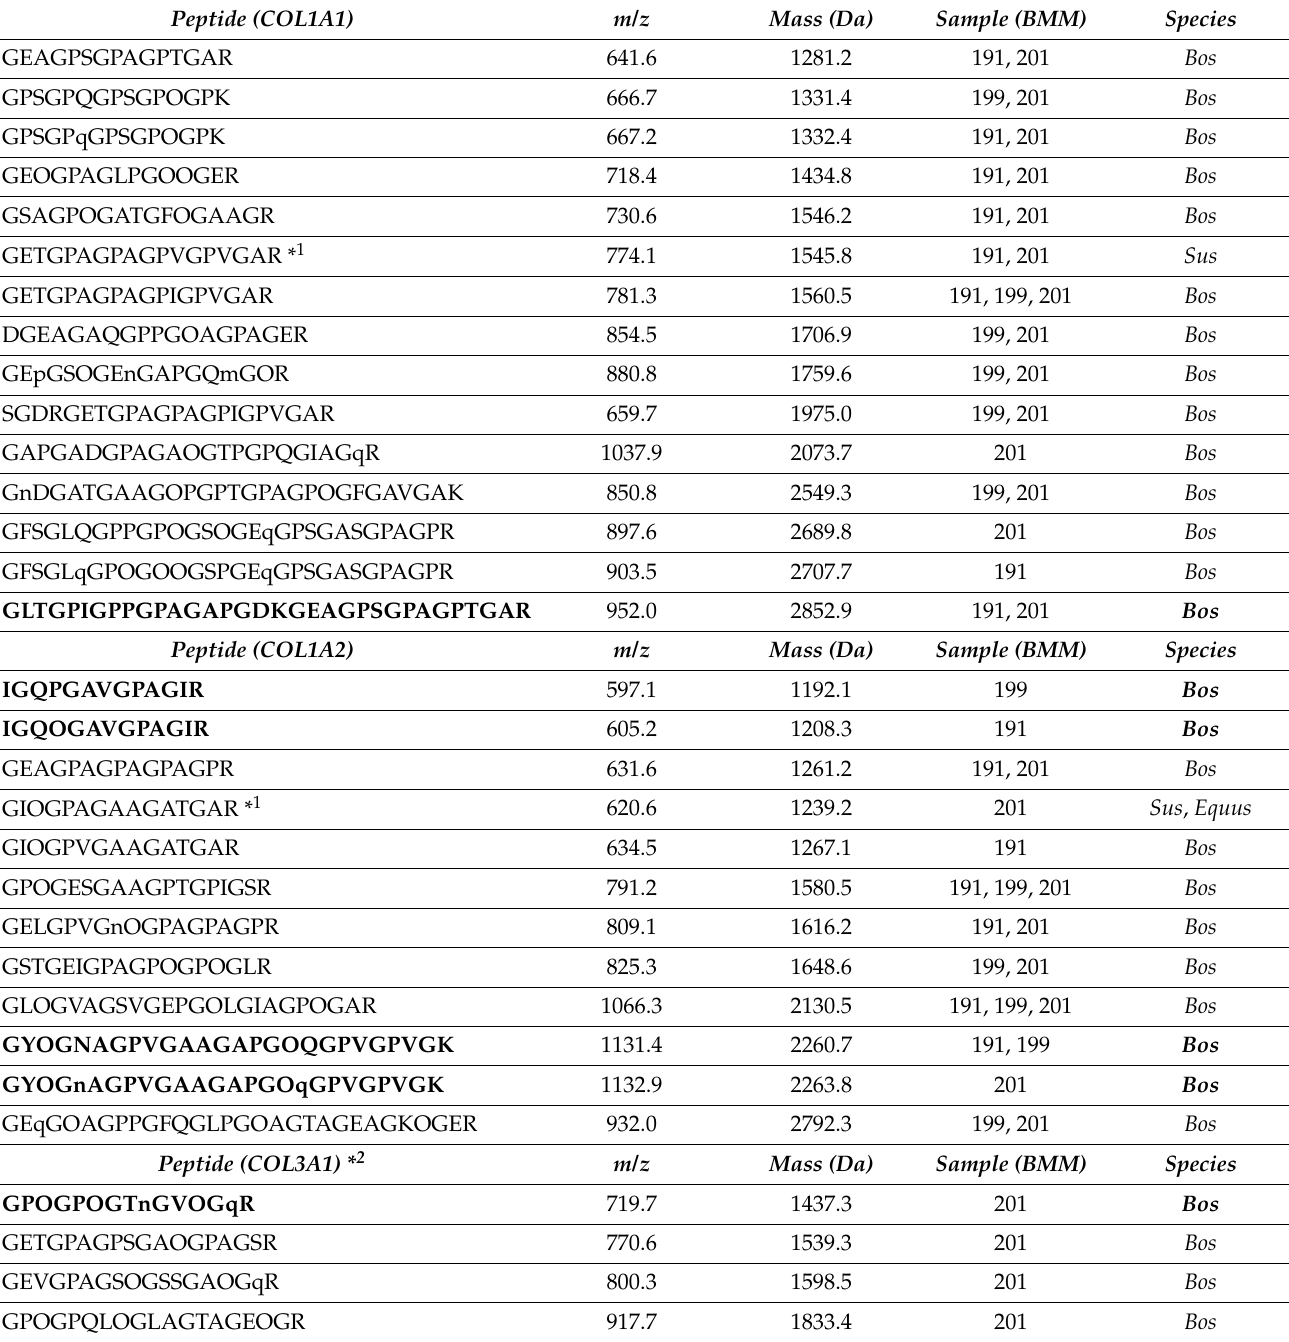
Table 9. Tryptic peptides identified originating from the type I collagen α 1-chain (COL1A1), α